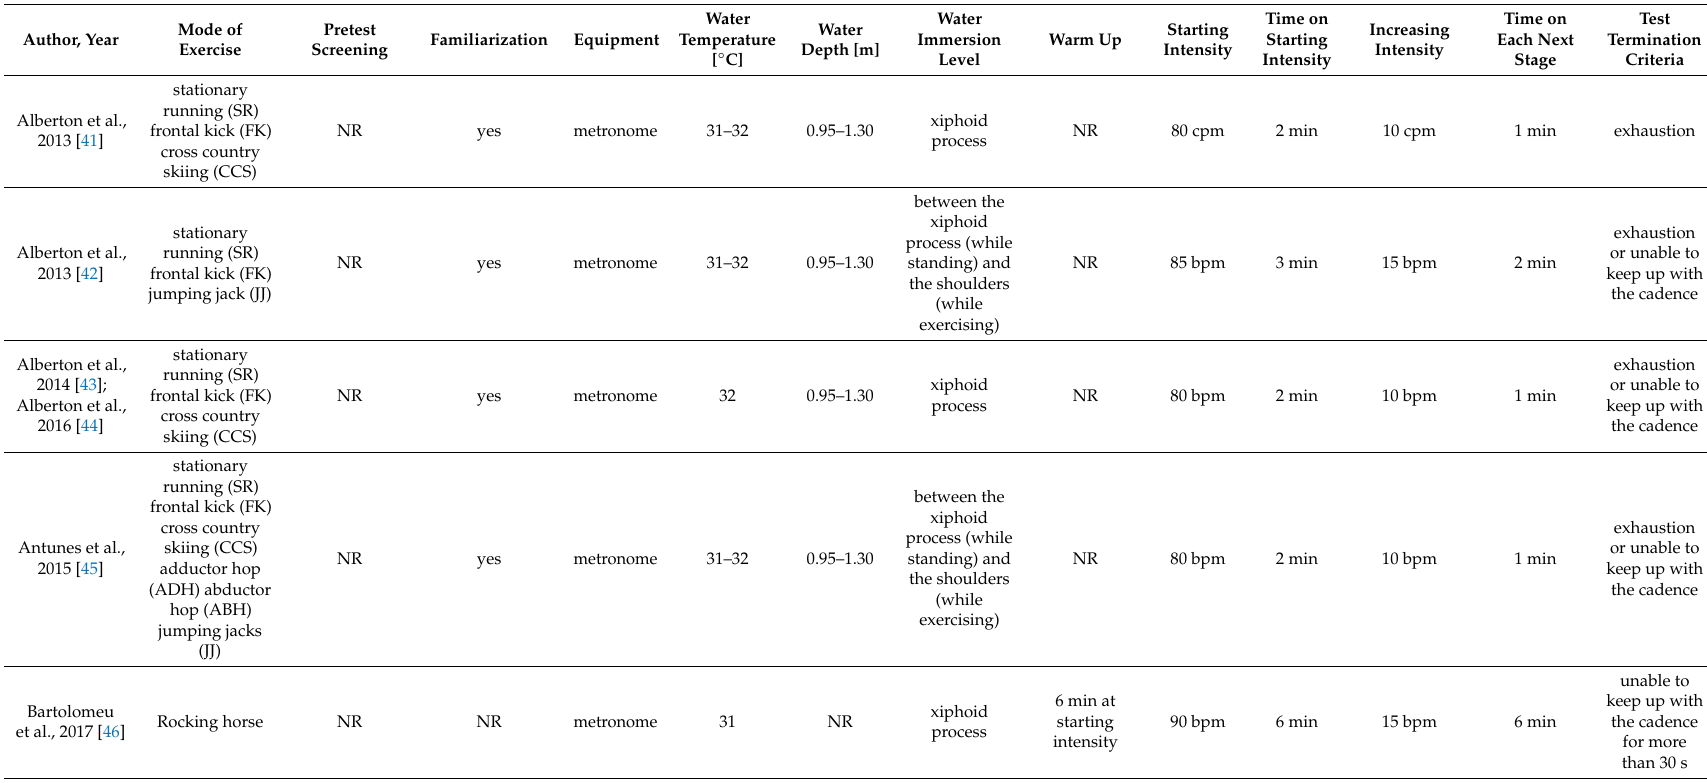
Table 1. Test protocols in shallow